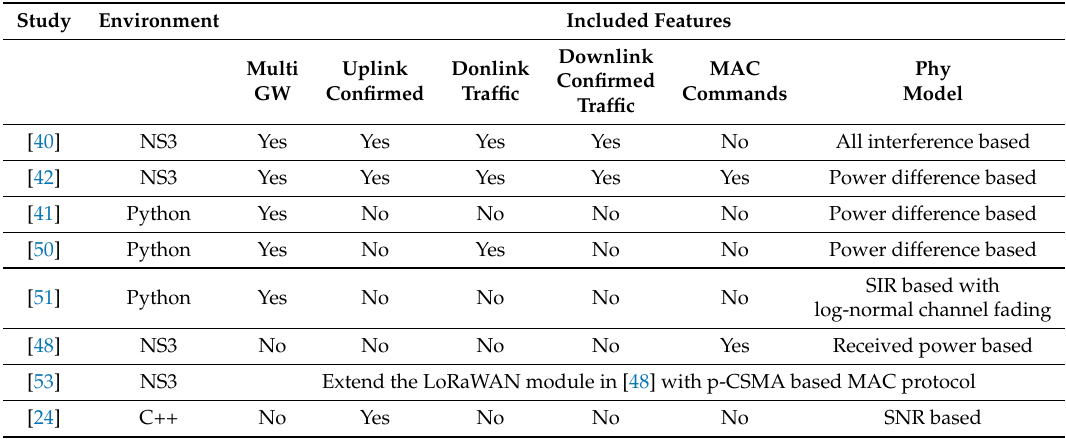
Table 4. LoRaWAN